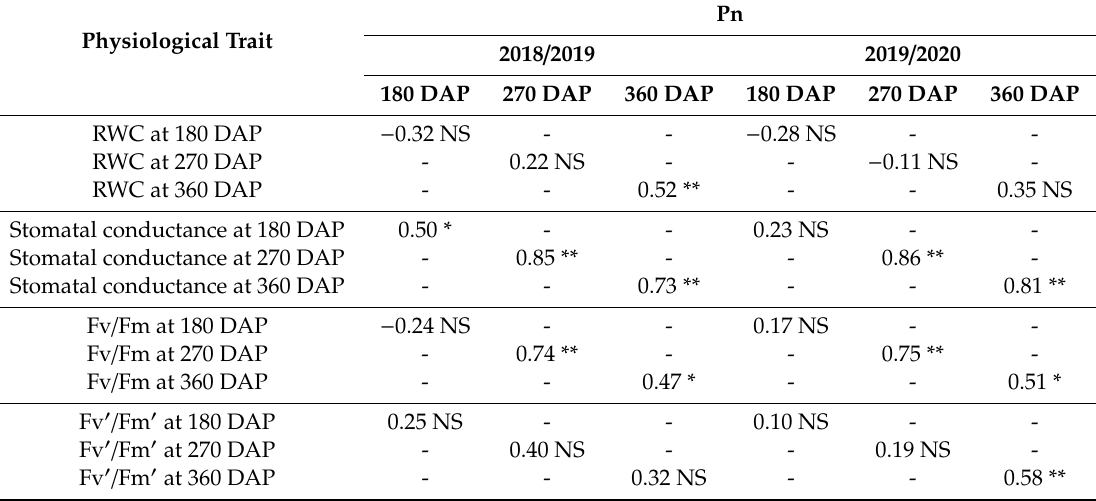
Table 7. Correlation coe ffi cients (r) between net photosynthesis rate (Pn) and other physiological traits (n =